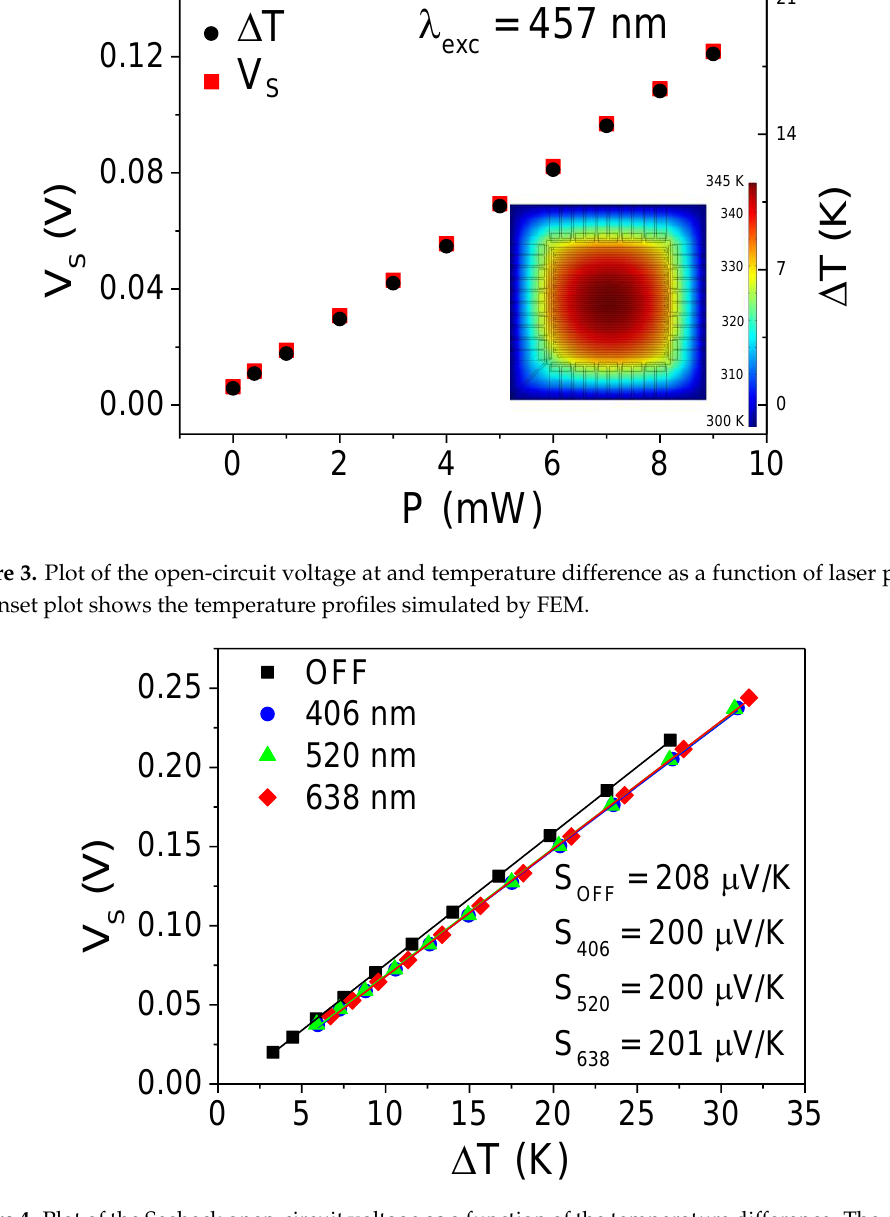
Figure 4. Plot of the Seebeck open-circuit voltage as a function of the temperature difference. The device is illuminated at 406 nm, 520 nm and 638 nm and without light.